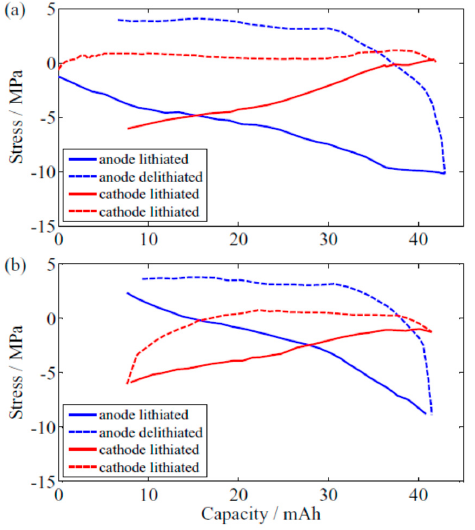
Figure 5. Electrode stress evolution at: ( a ) first cycle; and ( b ) second cycle [36].